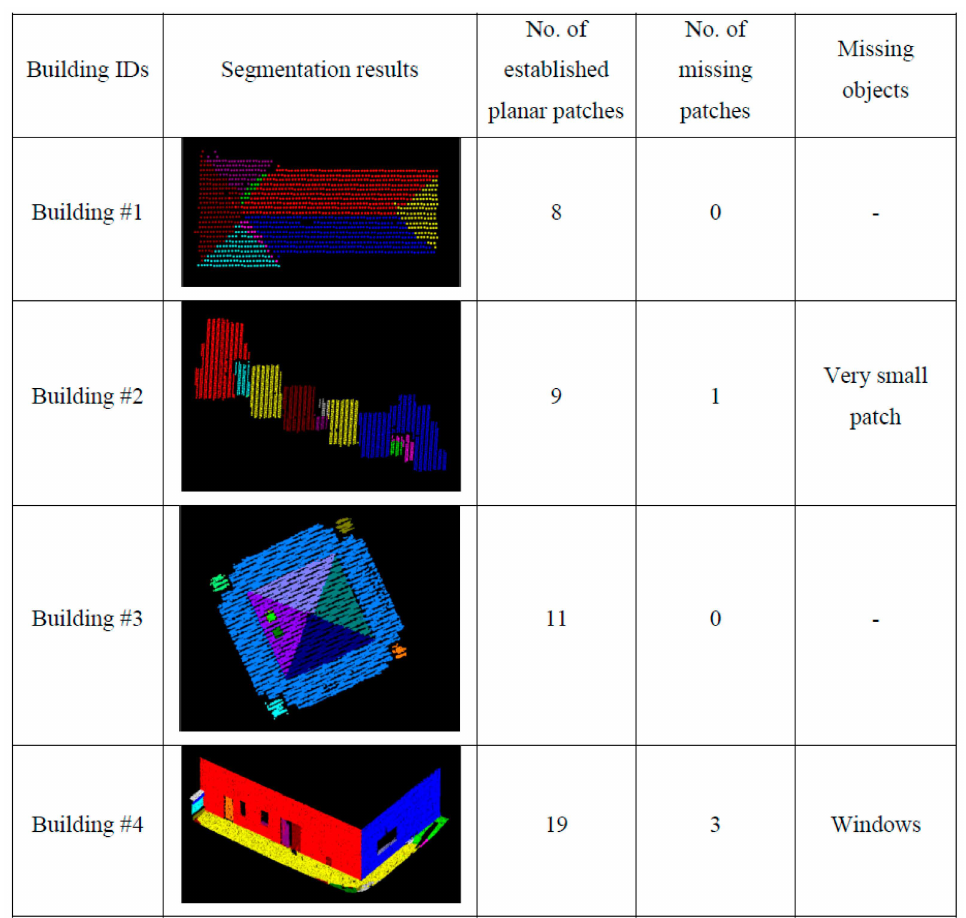
Figure 16. Segmentation results based on the adaptive cylindrical neighborhood